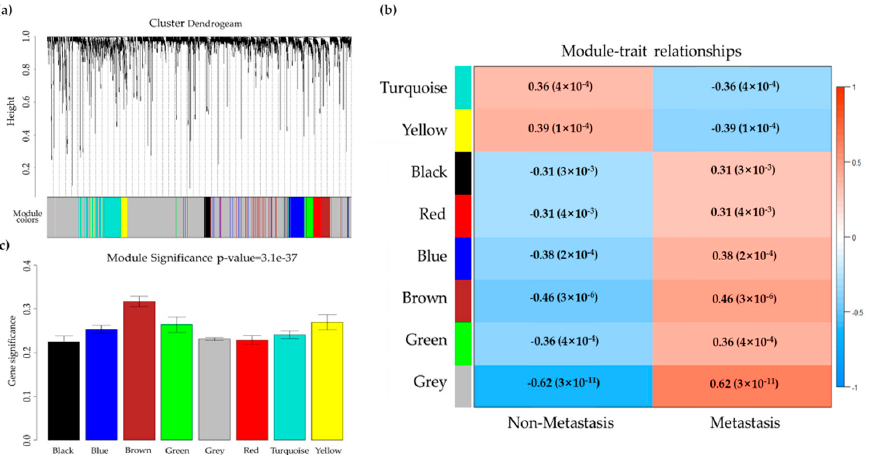
Figure 5. Identification of modules associated with the clinical traits of breast cancer. ( a ) Dendrogram of all differentially expressed genes clustered based on a dissimilarity measure (1-TOM). Eight modules were identified by WGCNA assay. ( b ) Heatmap of the correlation between module eigengenes and clinical traits of breast cancer. Two modules have non-metastasis related gene expression pattern and rest 6 modules have metastasis related gene expression pattern. ( c ) Distribution of average gene significance and errors in the modules associated with metastasis and non-metastasis breast cancer. The brown module was selected for assay because it had the highest gene significance in metastasis statement.